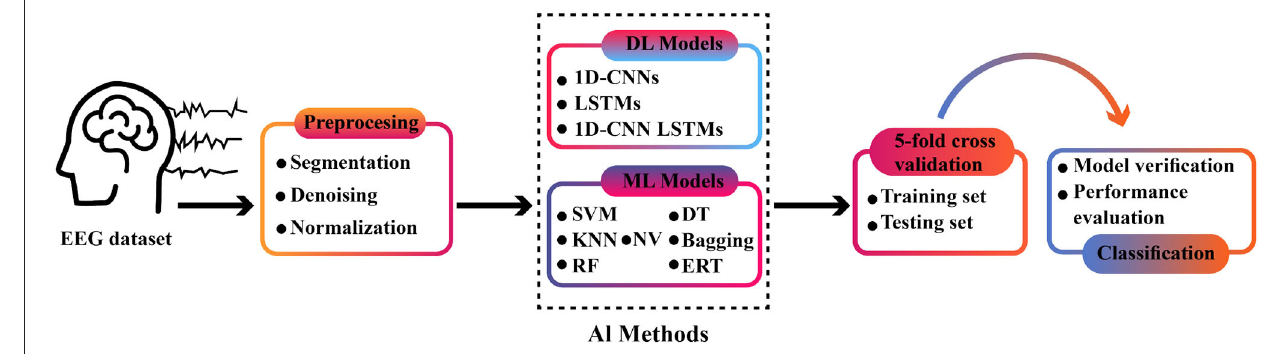
FIGURE 1 | The block diagram of proposed methods.